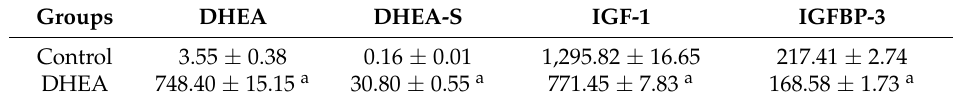
Table 2. Effects of DHEA supplementation on serum DHEA, DHEA-S, IGF-1, and IGFBP-3 (mean ±